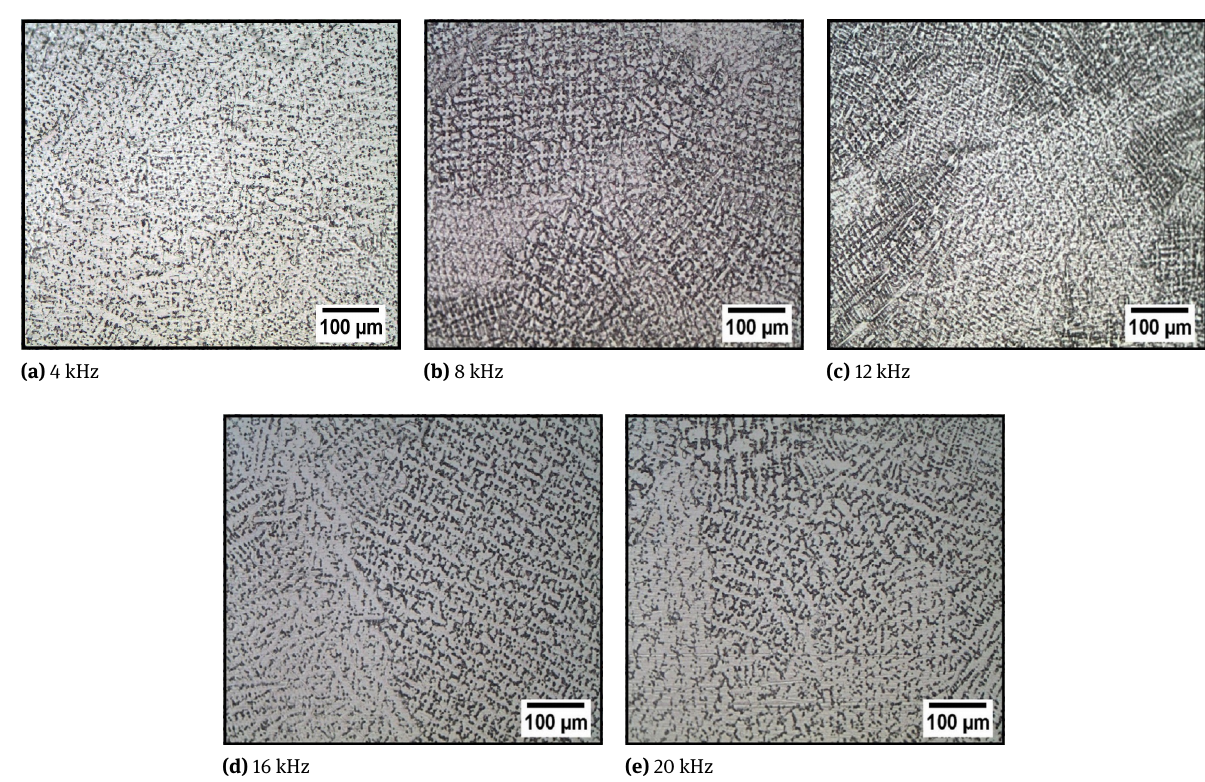
Figure 14: Effect of DCF on fusion zone (FZ) microstructure